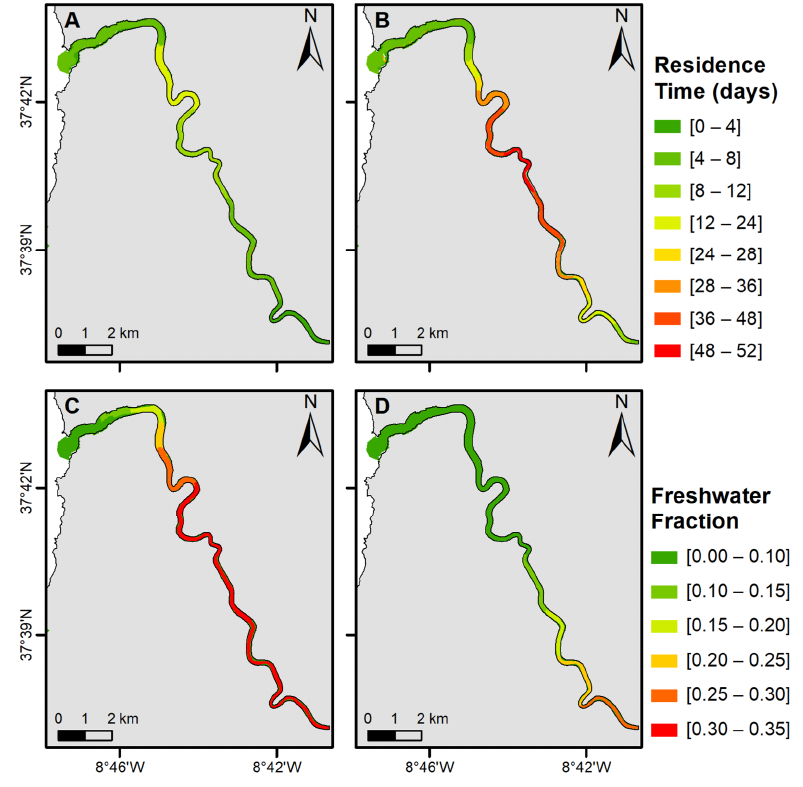
Figure 5. Mira Estuary residence time (days) and freshwater fraction for winter ( A , C ) and summer ( B , D )